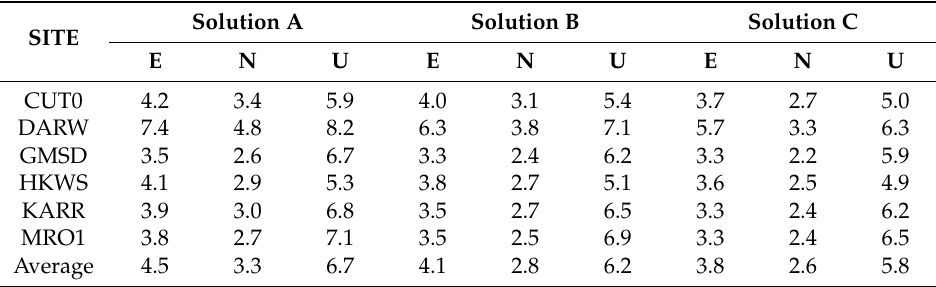
Table 5. The averaged positioning bias RMS with 2 h observation for each test